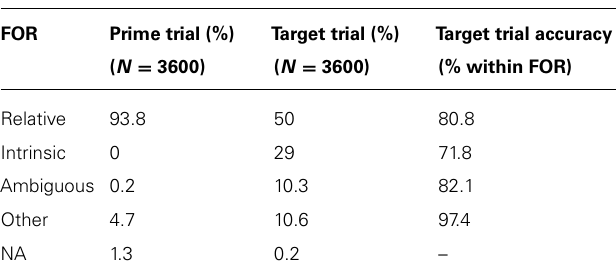
Table 1 | FOR selection and target trial accuracy.